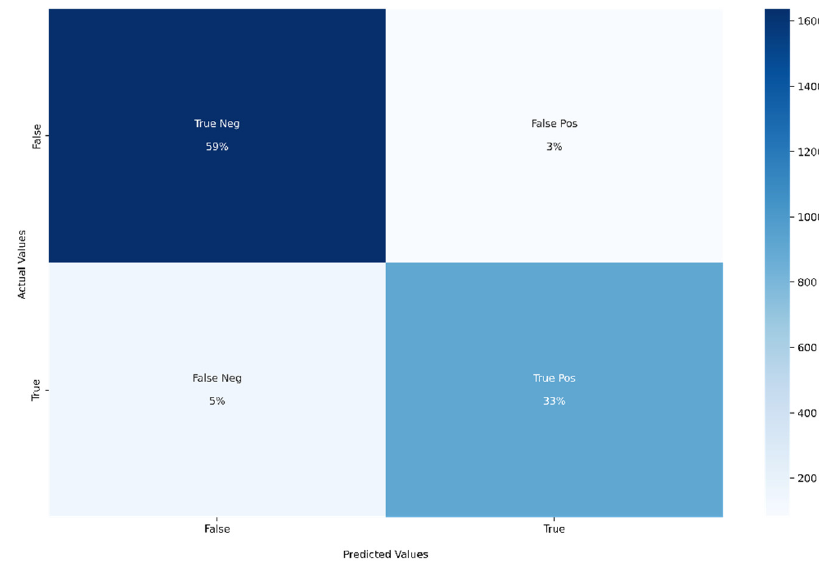
Figure 6. Confusion matrix of XGBoost algorithm.